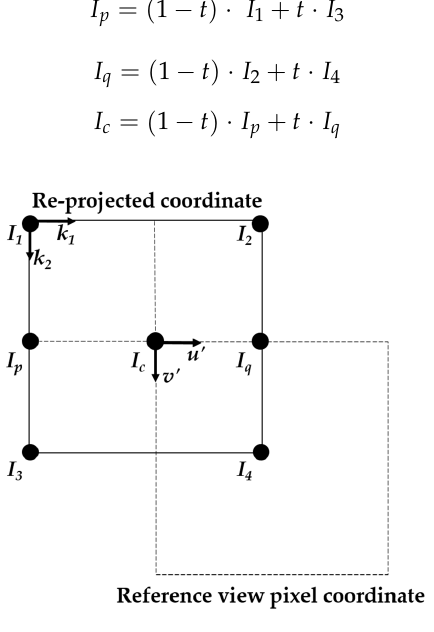
Figure 6. Bilinear interpolation for re-projected image. New intensity value of re-projected image I c in reference view image is defined by I p and I q .